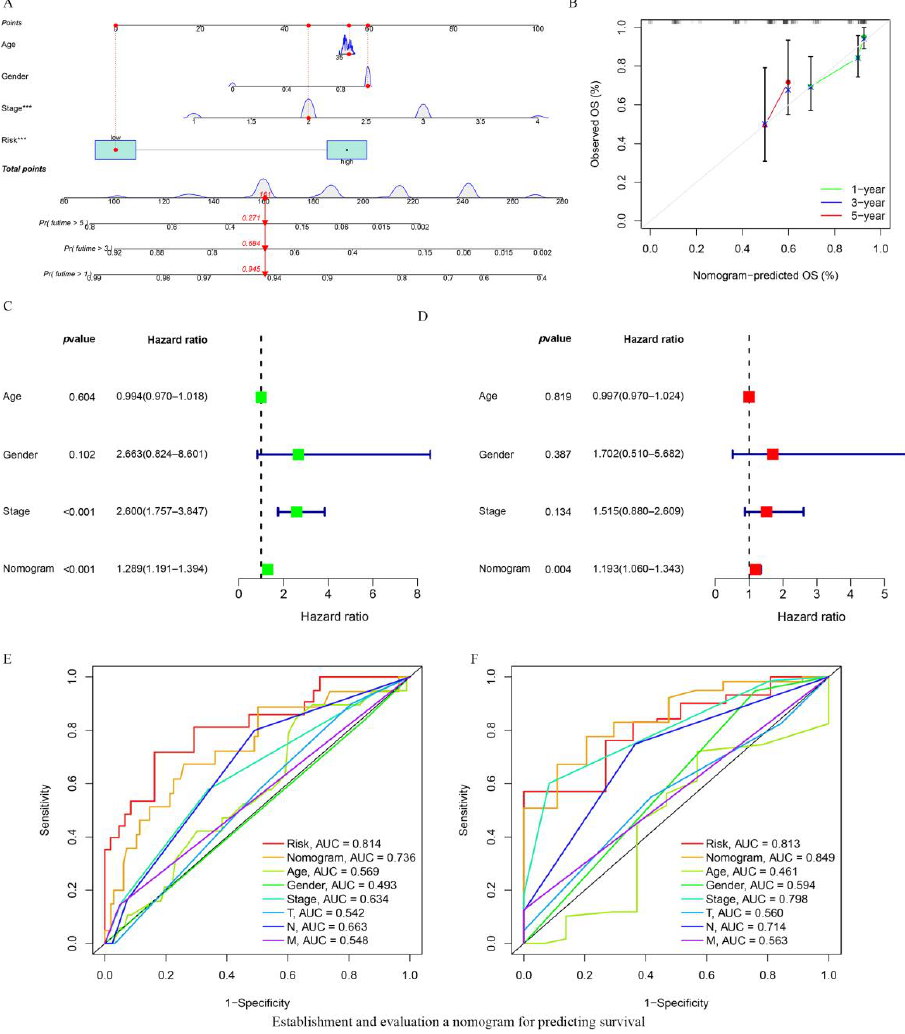
Figure 4. Establishment and evaluation a nomogram for predicting survival. ( A ) Nomogram predicting OS of ESCA patients. ( B ) The calibration plots of the nomogram. The x axis is nomogram-predicted survival, and the y axis is actual survival. ( C ) Univariate Cox regression analysis of the nomogram. ( D ) Multivariate Cox regression analysis of the nomogram. Red and green square represent HR value. ( E , F ) ROC curves at 1 and 3 years showing the predictive ability of the nomogram.